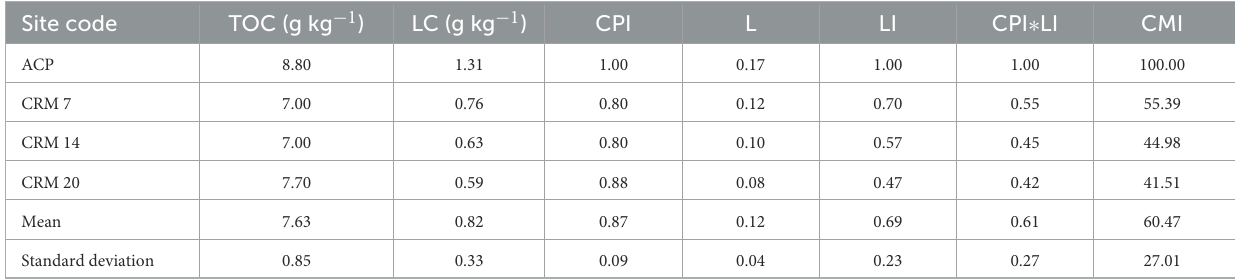
TABLE 5 Effects of different cropping systems on carbon management